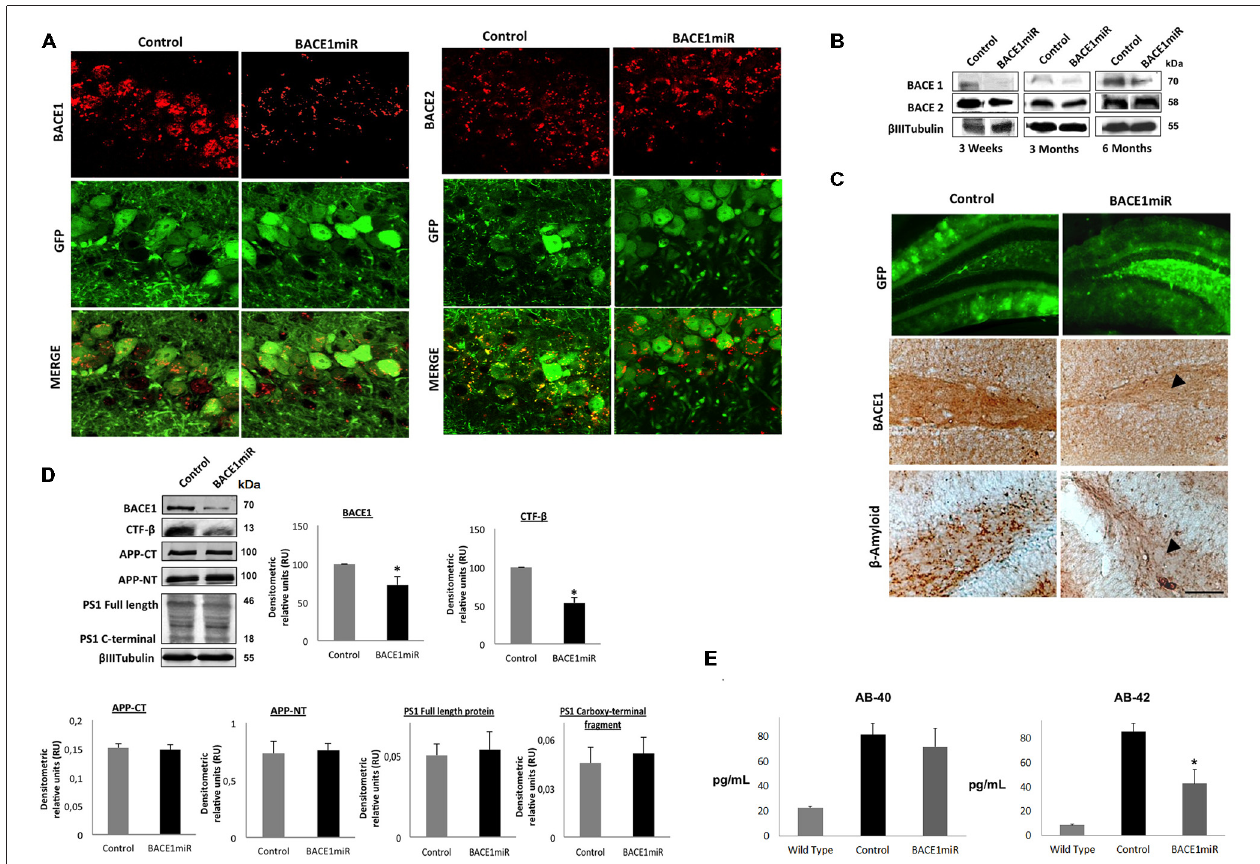
FIGURE 2 | BACE1miR produces specific BACE1 silencing and reduces β -amyloidosis in 3xTg-AD mice. (A) Representative confocal images of BACE1 and BACE2 immunofluorescence in the hippocampus from wild-type mice at 6 months after injection with AAV2/5-BACE1miR compared to mice with AAV2/5-GFP injection (Control). Green: GFP fluorescence, red: Alexa 594. 60 × magnification; scale bar: 20 µ m. n = 3. (B) Representative immunoblots showing BACE1 and BACE2 protein levels from the hippocampi of wild-type mice at 3 weeks, 3 months and 6 months after injection with AAV2/5-BACE1miR compared to the control values (AAV2/5-GFP). n = 3. (C) β -secretase 1 (BACE1) and β -amyloid immunoreactivities in the dentate gyrus (DG) of 18-month-old 3xTg-AD mice treated with AAV2/5-BACE1miR or AAV2/5-GFP as control for 6 months. The black arrowheads show the downregulation of the BACE1 and β -A immunostaining. Green: GFP fluorescence, adeno-associated virus (AAV) distribution in the DG. 40 × , scale bar: 20 µ m. n = 3. (D) Representative immunoblots showing BACE1, the C-terminal fragment (CTF- β ), APP-CT, APP-NT, full-length PS1 and the C-terminal fragment of PS1 from the hippocampi of 18-month-old 3xTg-AD mice evaluated at 6 months after injection of AAV2/5-BACE1miR or AAV2/5-GFP as a control. RU = relative units. n = 4, ∗ p < 0.05. (E) β -amyloid 1–40 and 1–42 levels from the hippocampi of 18-month-old 3xTg-AD mice were evaluated by ELISA at 6 months after the injection of AAV2/5-BACE1miR or AAV2/5-GFP; C57BL/6 mice were also used as controls. Absorbance was measured at 620 nm. n = 5, ∗ p < 0.05.